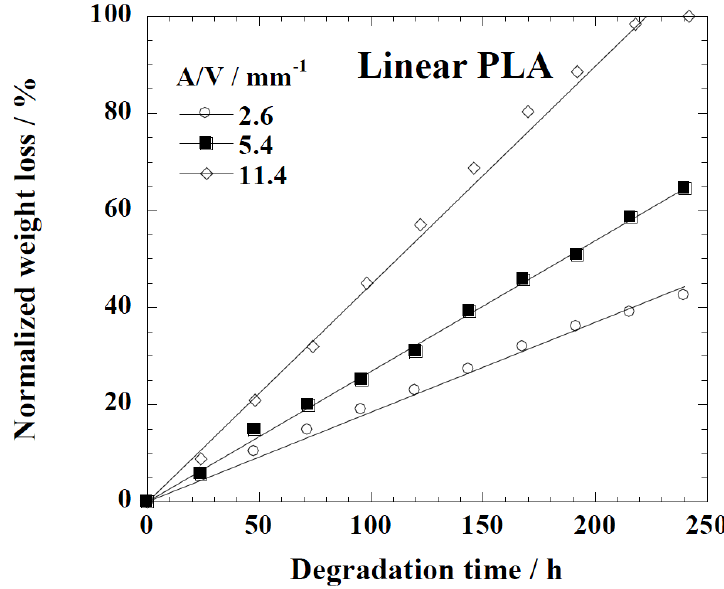
Figure 6. Normalized weight loss of linear polylactide (PLA) having different dimensions. The solid line was calculated by linear